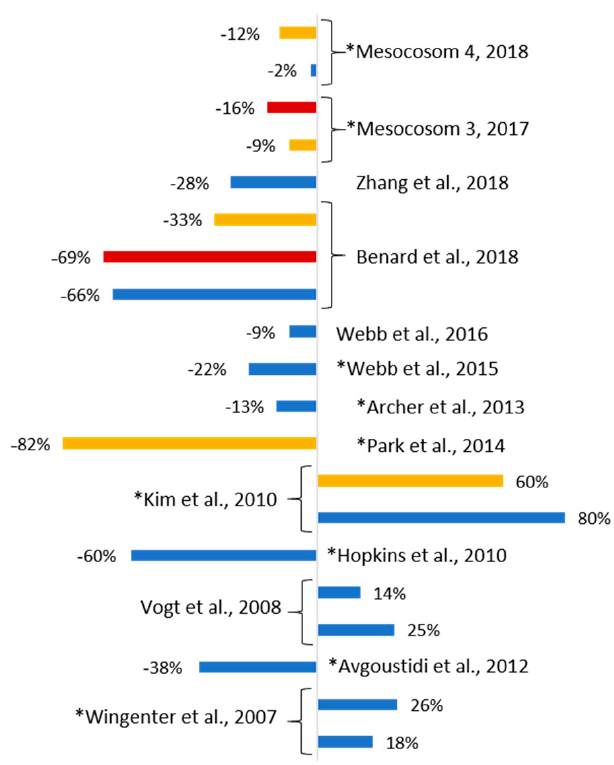
Figure 6. Comparison of DMS change in mesocosm studies. The percentage of DMS variation future to present is plotted. Blue bars represent “low pH” treatment (lowest pH of the experiments); yellow bars “pH/T” of end the 2100 scenario; red bar “2150 scenario”; * indicates nutrients addition. The results from the lowest pH and highest temperature are plotted for each